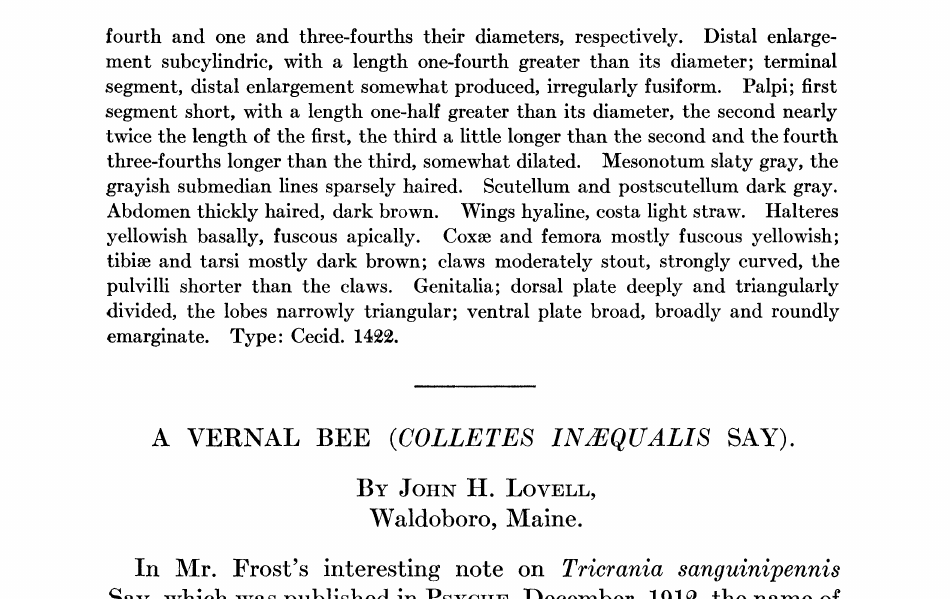
fourth and one and three-fourths their diameters, respectively. Distal enlarge- ment subcylindric, with a length one-fourth greater than its diameter; terminal segment, distal enlargement somewhat produced, irregularly fusiform. Palpi; first segment short, with a length one-half greater than its diameter, the second nearly twice the length of the first, the third a little longer than the second and the fourth three-fourths longer than the third, somewhat dilated. Mesonotum slaty gray, the grayish submedian lines sparsely haired. Scutellum and postscutellum dark gray. Abdomen thickly haired, dark brown. Wings hyaline, costa light straw. Halteres yellowish basally, fuscous apically. Coxe and femora mostly fuscous yellowish; tibiae and tarsi mostly dark brown; claws moderately stout, strongly curved, the pulvilli shorter than the claws. Genitalia; dorsal plate deeply and triangularly divided, the lobes narrowly triangular; ventral plate broad, broadly and roundly emarginate. Type: Cecid.